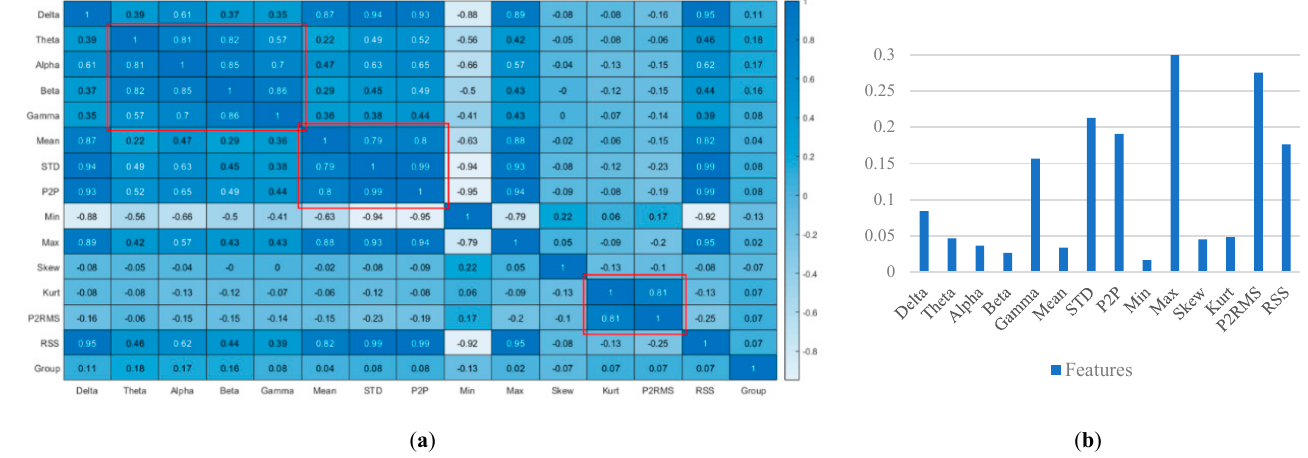
Figure 6. Correlation coefficient among features ( a ), p − value for each feature in group ( b ).